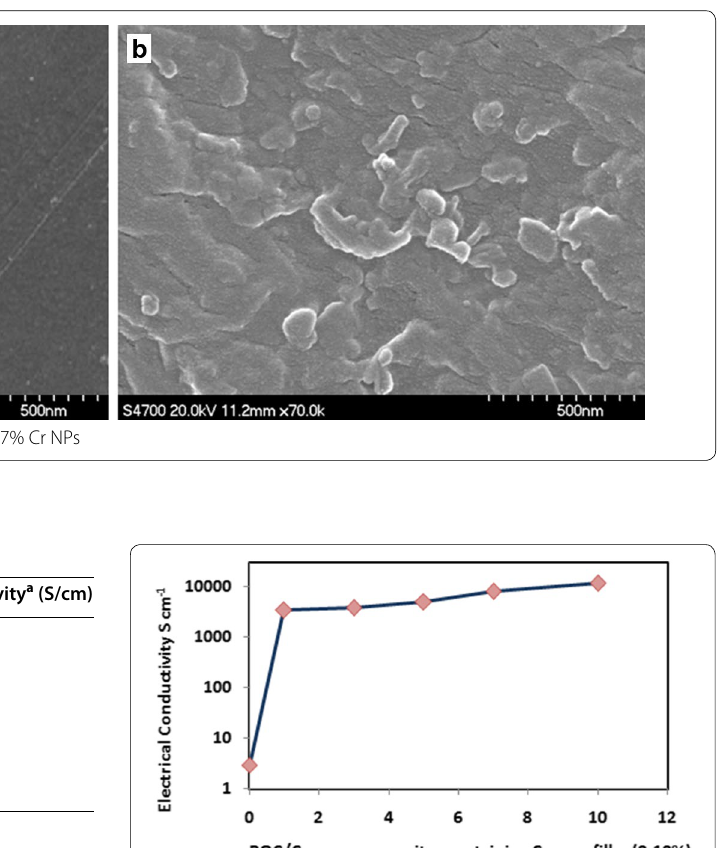
a At room temperature